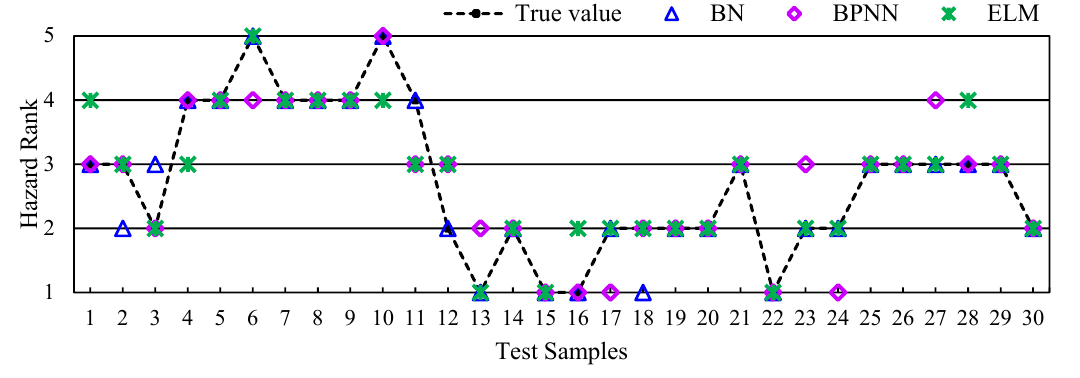
Figure 4. Assessment results of testing samples.